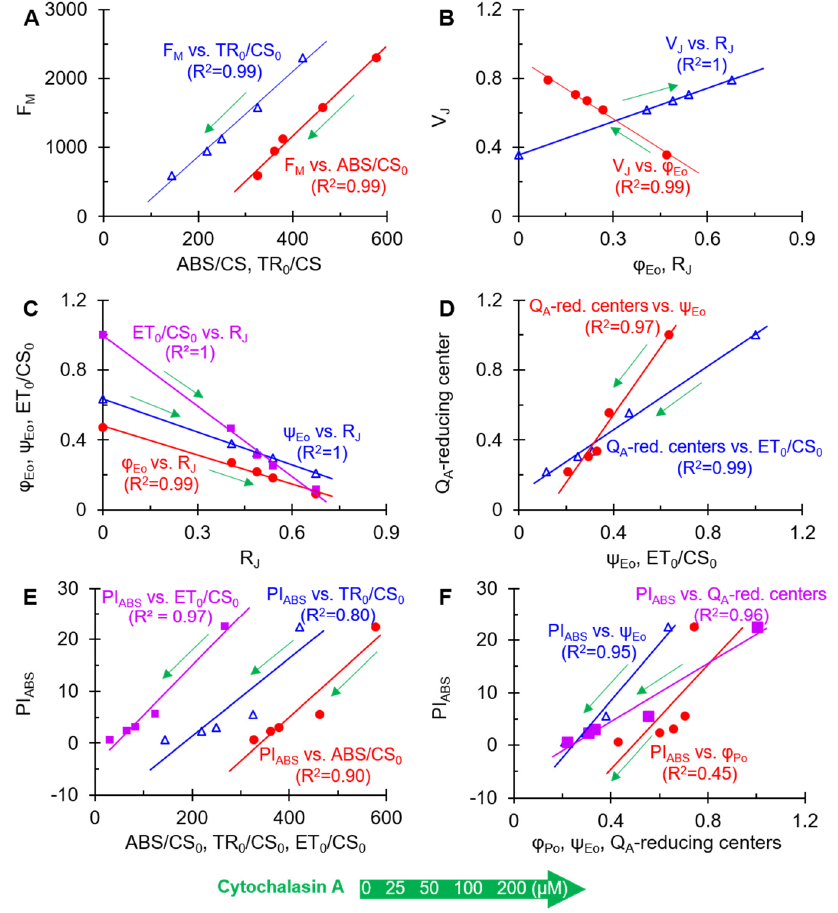
Figure 5. Analysis of the linear relationship between different selected JIP-test parameters after A. adenophora leaf discs were treated with different concentrations of cytochalasin A for 12 h. ( A ) The ABS/CS and TR 0 /CS versus F M . ( B ) The φ Eo and R J versus V J . ( C ) The R J versus φ Eo , ψ Eo and ET 0 /CS 0 . ( D ) The ψ Eo and ET 0 /CS 0 versus Q A -reducing centers. ( E ) The ABS/CS 0 , TR 0 /CS 0 and ET 0 /CS 0 versus PI ABS ( F ) The φ Po , ψ Eo and Q A -reducing centers versus PI ABS . Each curve is the average of three independent experiments with around 15 repetitions.